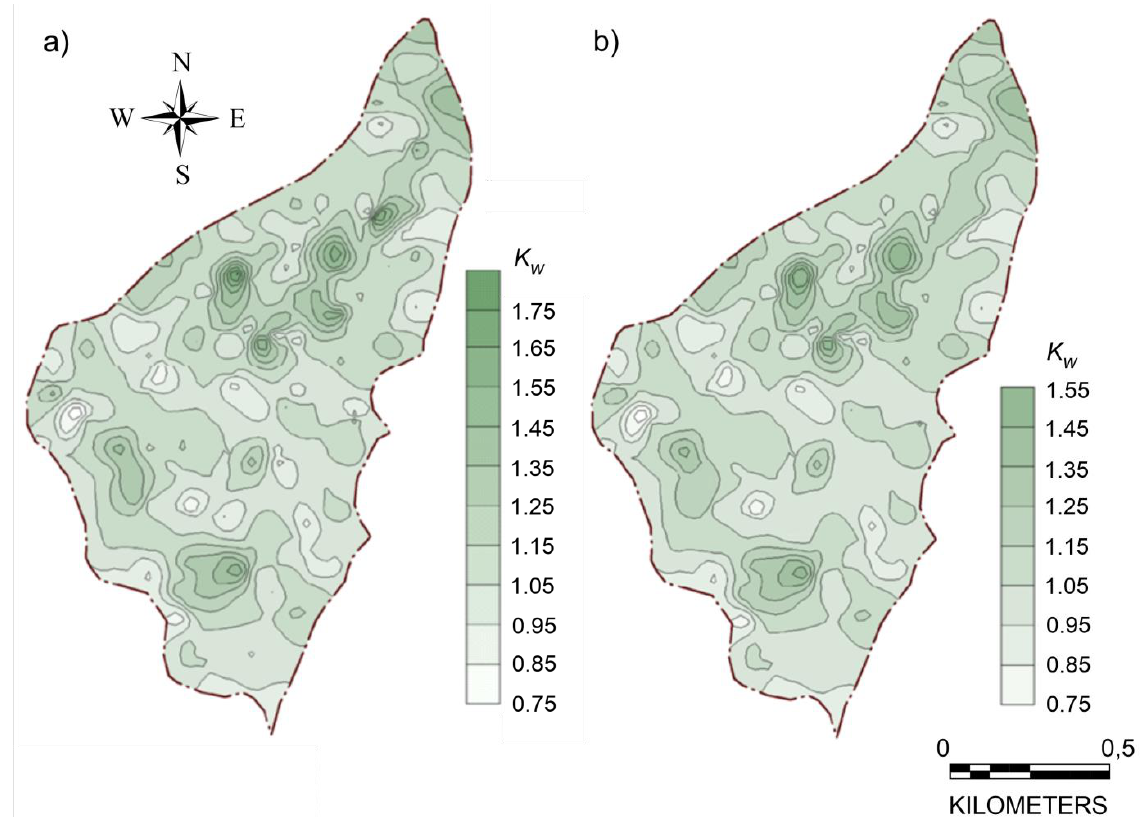
Figure 5. Spatial distribution of the soil moisture ratio in the Mątny basin generated using: ( a ) the MLP 9-4-1 model, and ( b ) based on measured data elaborated by kriging technique. Table 6. Model efficiency measures for the MLP 9-4-1. Model Efficiency